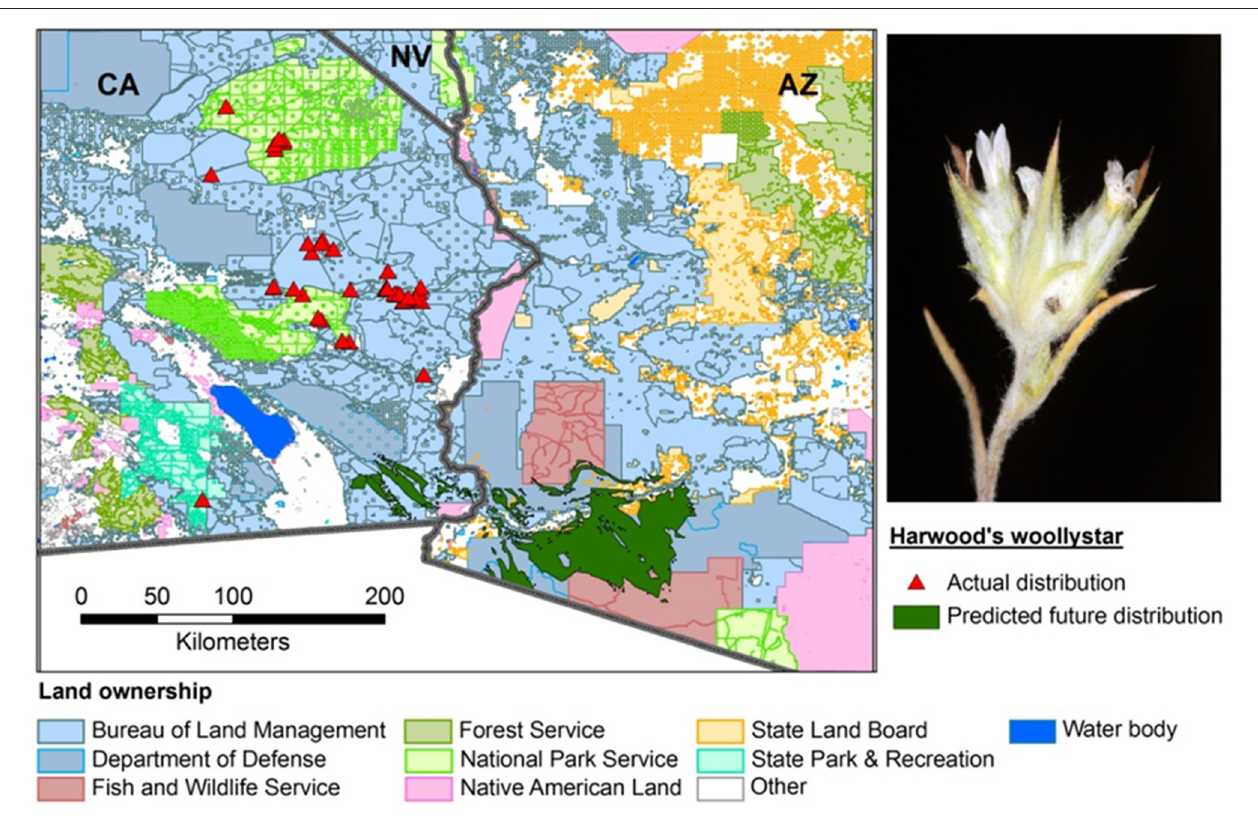
FIGURE 1 | Harwood’s woolly star is currently endemic to California and protected on state and federal land. Under a moderate warming scenario, suitable habitat for this plant might shift to the southeast, forcing it to traverse a fragmented regulatory landscape. Populations arriving in Arizona might lose state and federal protection (see